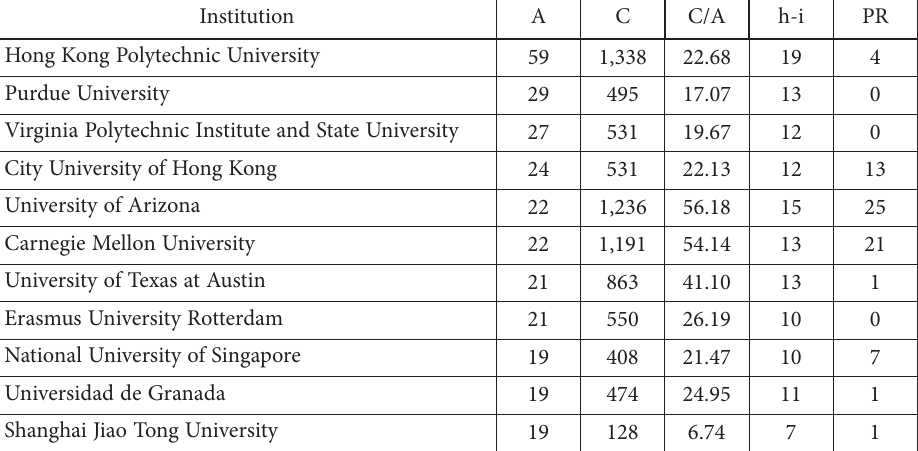
Table 4. Institutions promoting